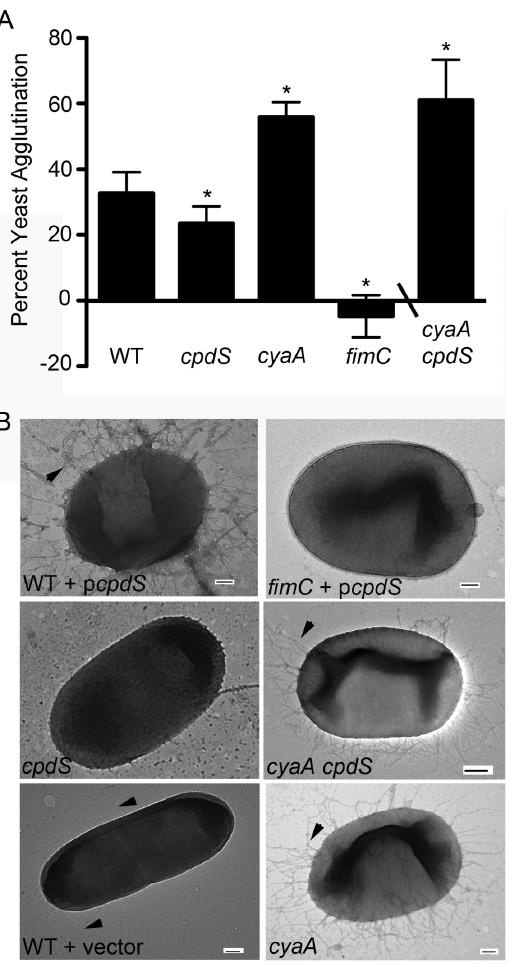
Figure 5. The cpdS mutant has reduced surface fimbriae. A. A yeast-agglutination assay was used to quantitate relative fimbriae expression. The asterisk indicates statistical difference from wild-type levels (n=9, p , 0.05, ANOVA with Tukey’s post-test or Student’s T-test). The cyaA cpdS double mutant data was from a different experiment (n=6). B. Representative TEM micrographs of relevant strains. Black arrow-heads indicate fimbriae. Bar =100 m m.